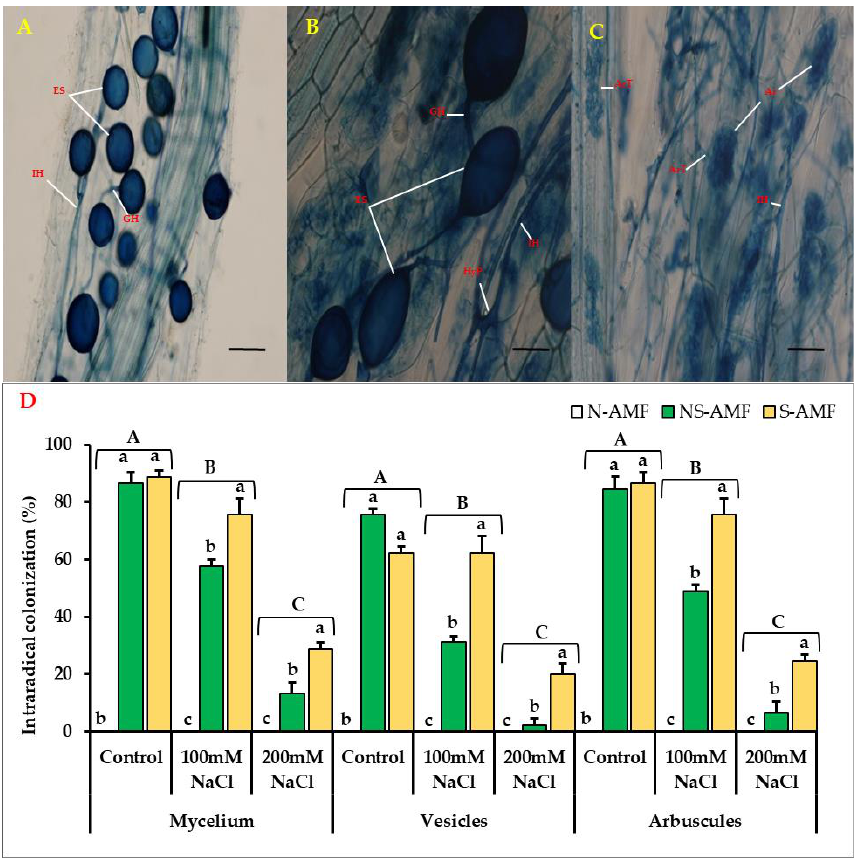
Figure 2. Showing photomicrographs indicating the perfect abundance of arbuscular mycorrhizal colonization in the roots of L. scindicus plants cultivated under salt stress. ( A – C ) the presence of hyphopodium (HyP) indicated AMF colonization, which later propagated and developed various structural forms. Extraradical intact spores (ES); intercellular hyphae (IH); germinating hyphae (GH); arbuscular trunk (ArT); arbuscules (Ar). ( D ) salt stress on the root colonization of L. scindicus plants inoculated with S-AMF and NS-AMF. Capital letters indicate the significance of the salinity effect, while small letters indicate AM symbiosis status at p = 0.05 (Tukey’s HSD test). Table 1. Effect of Salt stress on the spore count of Sabkha and non-Sabkha AMF. Treatment